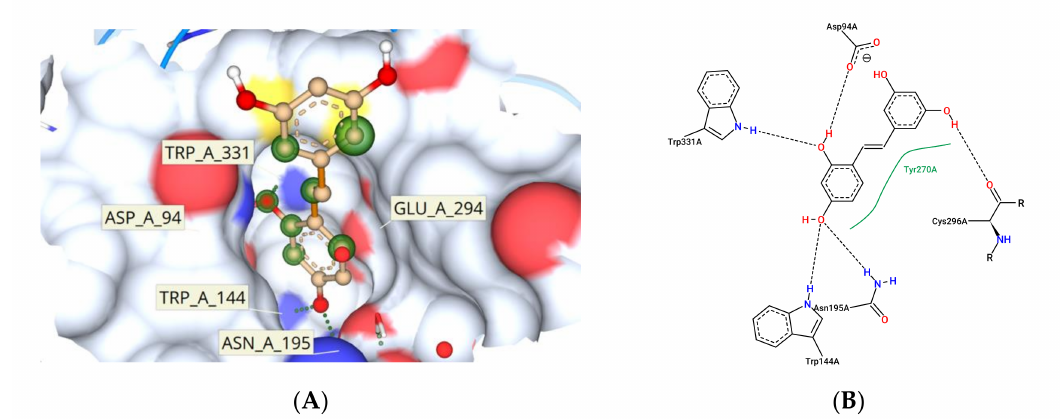
Figure 18. Oxyresveratrol bound to SrfJ protein. ( A ) Three-dimensional depiction of the interaction with key amino acids. ( B ) Two-dimensional depiction of the protein–ligand interaction highlighting the amino acids with hydrogen bonds as well as hydrophobic interactions.